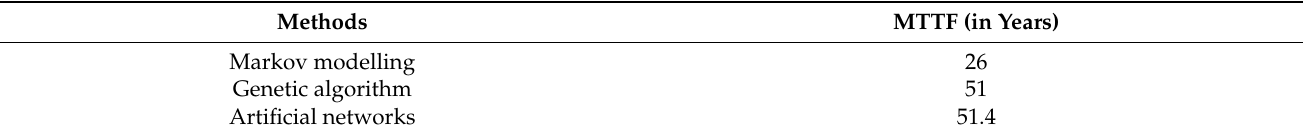
Table 3. Parameter